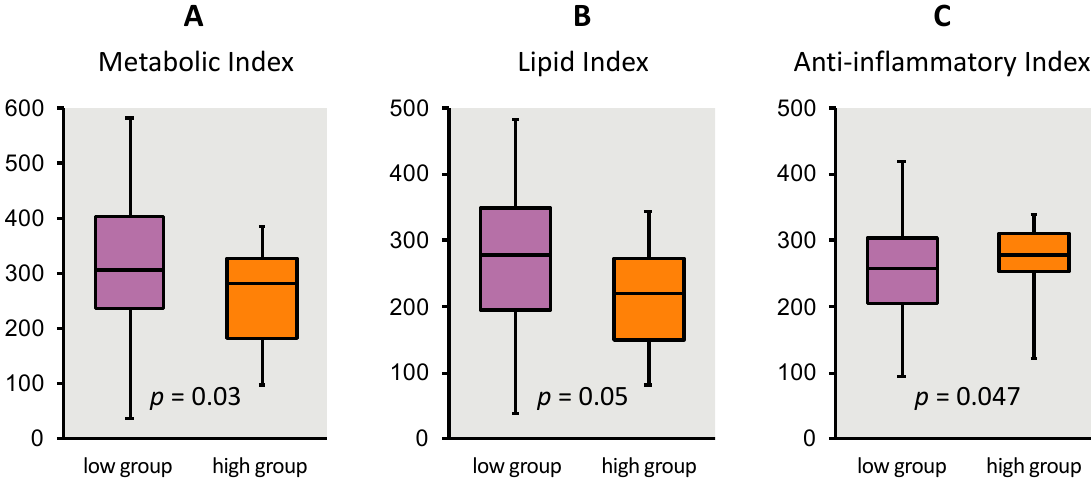
Figure 4. Child biomarker indices for metabolic ( A ), lipid ( B ) and anti-inflammatory ( C ) stratified by Niños Sanos groups of low and high scores. Answers on Niños Sanos, final version with 18 items, were scored and discretized into 2 groups of low and high scores (51.5 to 74.9 points; 75.0 to 80.5 points). Metabolic index ( A ) composed of glucose, insulin, leptin, leptin:adiponectin. Lipid index ( B ) composed of triglycerides, high density lipoprotein (HDL) cholesterol, low density lipoprotein cholesterol, cholesterol:HDL cholesterol. Anti-inflammatory index ( C ) composed of Interleukin 10, adiponectin and IGFBP-1 insulin growth factor binding protein, resistin and C-reactive protein.